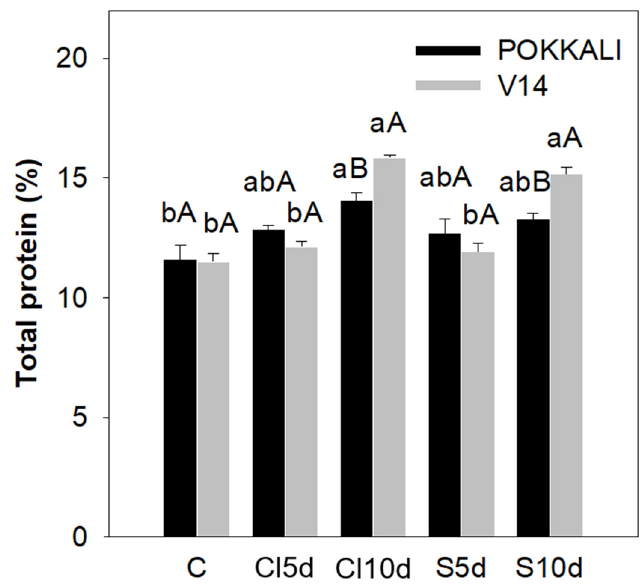
Figure 3. Total protein content in the rice grain of control plants (C) and plants stressed by 5 dS m − 1 (5d) or 10 dS m − 1 (10d) of NaCl (Cl) or Na 2 SO 4 (S). Each value is the mean of three replicates per treatment and vertical bars are standard errors of the mean. Treatments followed by the same lowercase letter for a particular cultivar do not differ statistically. Cultivars followed by the same uppercase letter in a particular treatment do not differ statistically.